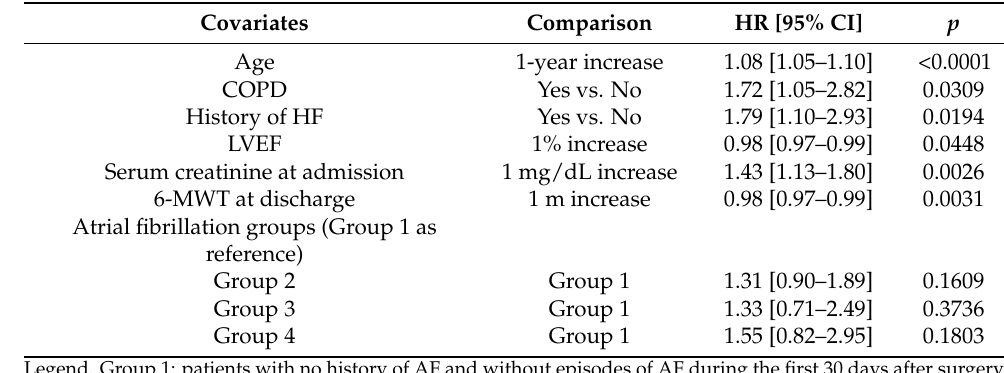
Table 3. Multivariable model (see text for details) investigating the independent prognostic value of atrial